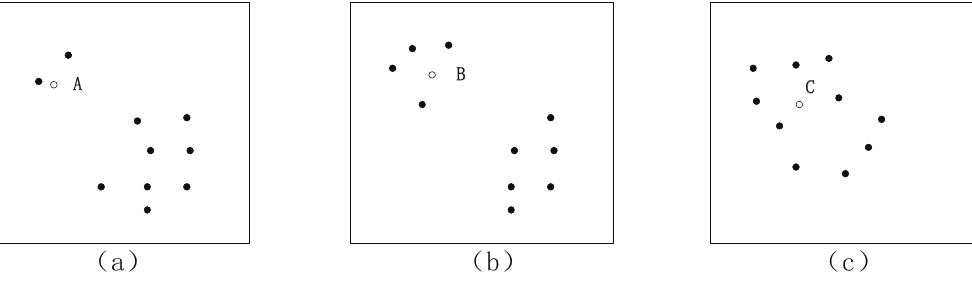
Figure 3. Data distribution scatterplot for different